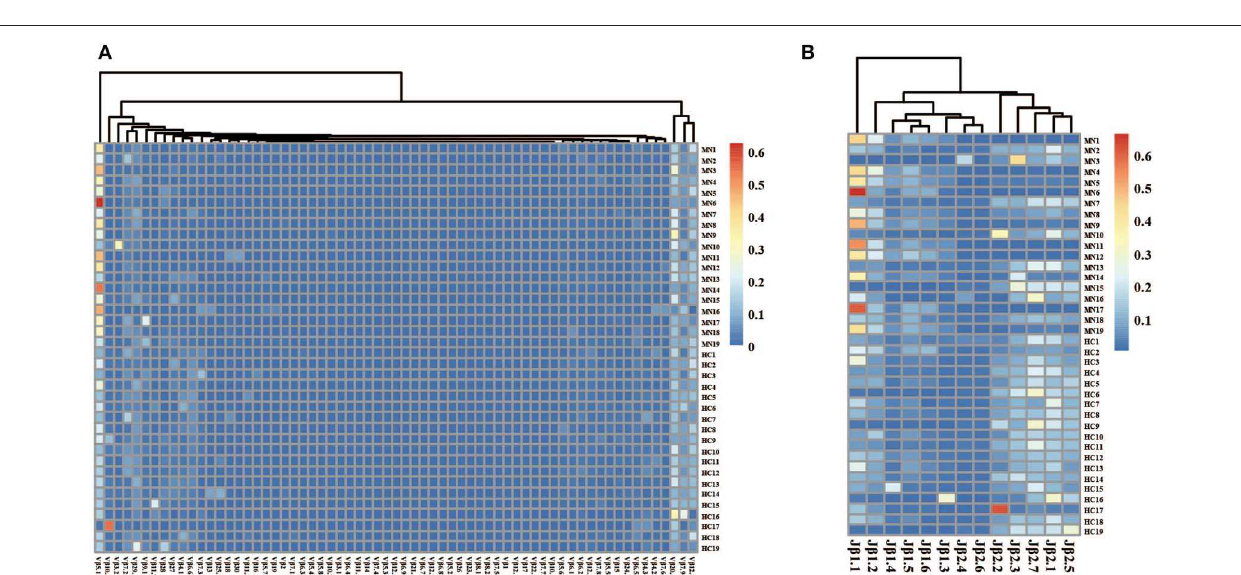
and J β gene usage between two groups, significant differences were observed in almost half of the V β and J β genes (27/65 V β gene and 8/13 J β genes, Figures 3A,B ), which indicated that the usage patterns of V β and J β genes were skewed in MN patients.